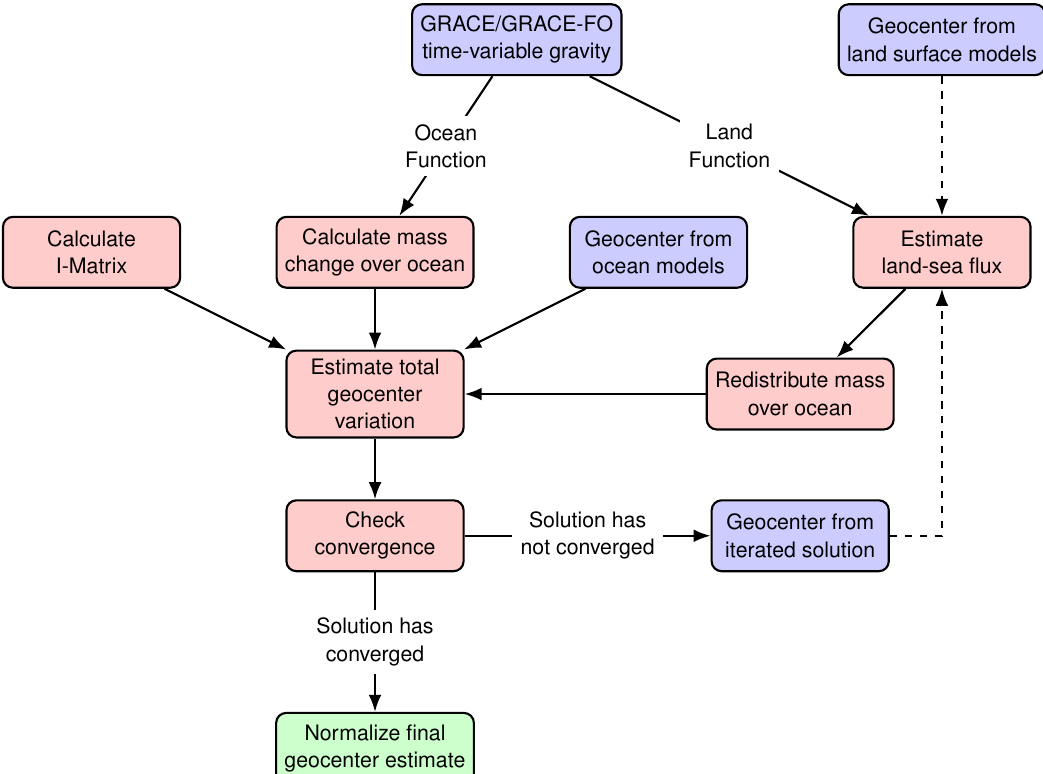
Figure 2. Flowchart of our processing scheme for estimating geocenter variations from time-variable gravity data and ocean model outputs. Blue nodes denote datasets, red nodes denote calculations, and the green node denotes the final converged